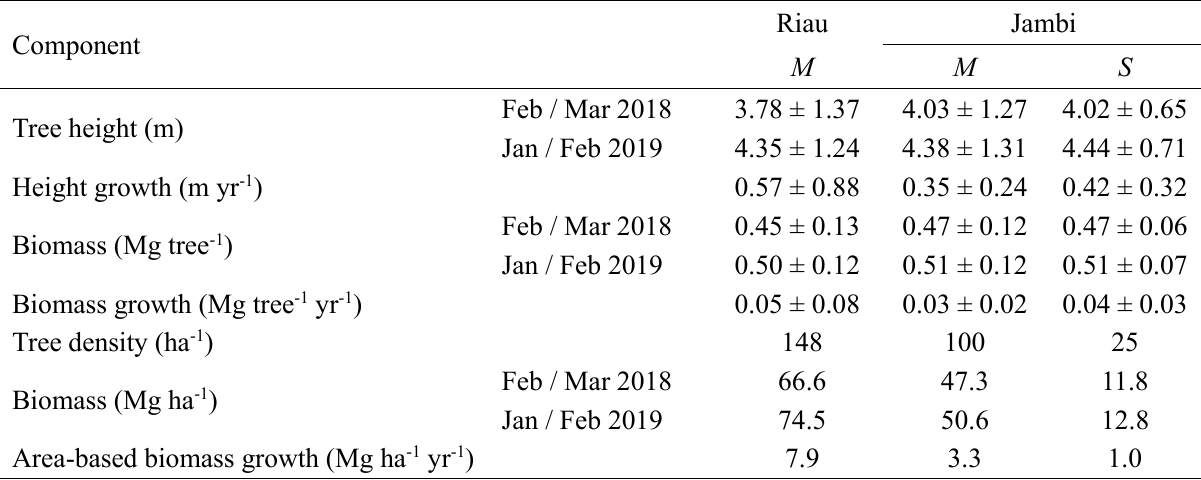
Table 3. Tree height and canopy biomass (mean ± 1 SD; n = 32, 20 and 5 for M in Riau, M in Jambi, and S in Jambi,